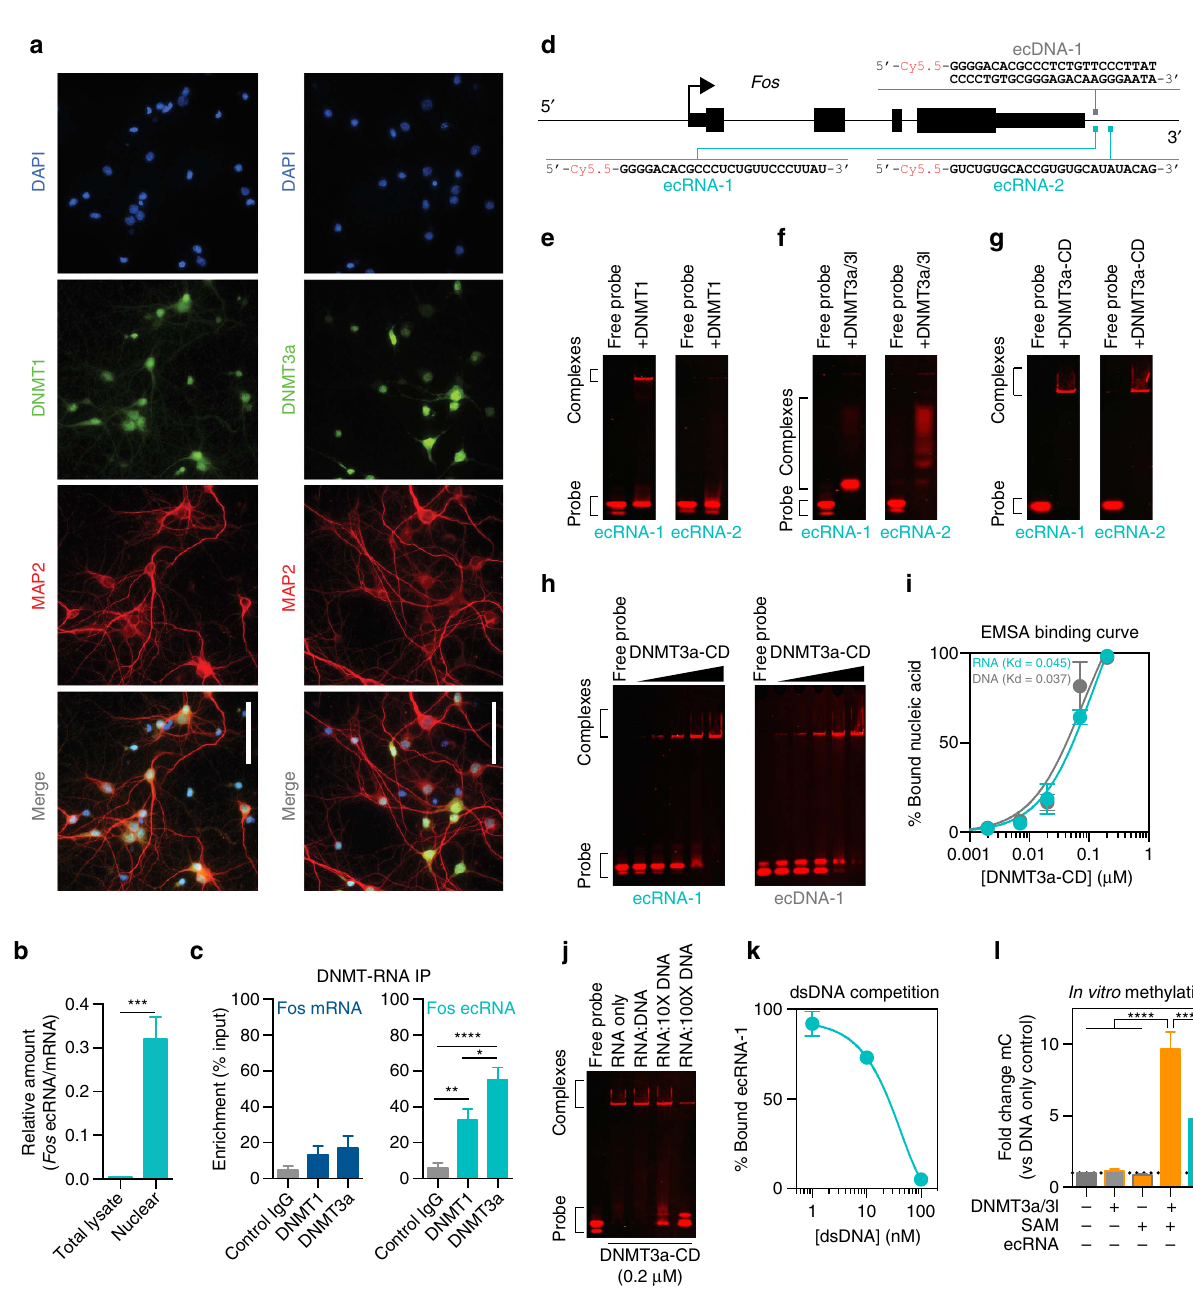
Figure 5 | Fos ecRNA interacts with DNA methyltransferases and blocks DNA methylation. ( a ) Immunostaining reveals nuclear localization of DNMT1 and DNMT3a in neuronal cultures. Cell nuclei are stained with 4,6-diamidino-2-phenylindole (DAPI), and neurons are marked by MAP2 (microtubule- associated protein 2). Scale bar, 50 m m. ( b ) Fos ecRNA/mRNA comparison in total neuronal lysate and nuclear fraction (separated during RNA-IP; n ¼ 4 per group; unpaired Student’s t -test, t 6 ¼ 6.301, P ¼ 0.007). ( c ) Fos ecRNA, but not mRNA, immunoprecipitates with anti-DNMT1 or DNMT3a antibodies but not control IgG ( n ¼ 4–6 per group; ecRNA one-way ANOVA, F (2,15) ¼ 20.53, P o 0.0001; Tukey’s post hoc test for individual comparisons). ( d ) Locations of synthetic RNA and DNA oligonucleotides used in mobility shift assays. ( e ) Electrophoretic mobility shift assay reveals only slight binding of ecRNA probes (1nM) to recombinant DNMT1 (0.2 m M). RNA/DNMT complexes are evident as low-mobility band on native PAGE gel following incubation with DNMT protein. ( f ) Synthetic ecRNA probes (1nM) bind recombinant DNMT3a/DNMT3l protein (0.2 m M). ( g ) Complete binding of synthetic ecRNA probes (1nM) to truncated recombinant DNMT3a protein (0.2 m M) containing only catalytic domain (DNMT3a-CD). ( h ) Incubation of ecRNA-1 or ecDNA-1 probes (1nM) with escalating concentrations of DNMT3a-CD (0.002–0.2 m M). ( i ) DNMT3a-CD binds equally to RNA and double-stranded DNA with the same primary sequence. Binding affinity (Kd values; derived from non-linear, one-site regression analysis of complete concentration curve) for RNA and dsDNA was not significantly different ( n ¼ 2 replicates; comparison of Kd, F (1,22) ¼ 0.47, P ¼ 0.49). ( j ) Competition assay between ecRNA-1 (1nM) and unlabelled ecDNA-1 probes (1–100nM) shows intact RNA/DNMT3a-CD complexes even with 10-fold higher concentrations of DNA. ( k ) Quantification of dsDNA competition assay. ( l ) Co-incubation of DNMT3a/3l protein and the methyl donor SAM results in cytosine methylation at dsDNA (3.42nM) from the Fos promoter. Methylation was significantly inhibited by addition of ecRNA (5.16 m M). For ( l ) n ¼ 4 per group, one-way ANOVA, F (4,15) ¼ 40.25, P o 0.0001; Tukey’s post hoc test for individual comparisons. All data are expressed as mean ± s.e.m. Individual comparisons, * P o 0.05, ** P o 0.01, *** P o 0.001 and **** P o 0.0001. NATURE COMMUNICATIONS|7:12091|DOI: